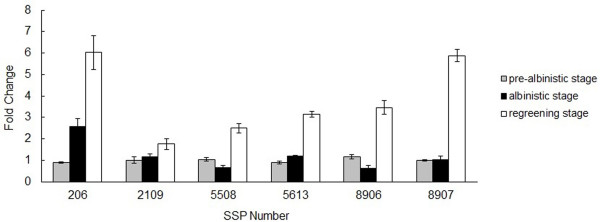
Real-time PCR analysis of the transcript levels of differentially expressed proteins at three developmental stages. SSP 206, phosphoglycerate kinase; SSP 2109, Early light-induced protein; SSP 5508, S-adenosylmethionine synthetase; SSP 5613, glutamine synthetase; SSP 8906, enolase; SSP 8907, heat shock protein 60-2.